Question: Produce a descriptive caption suitable for publication.
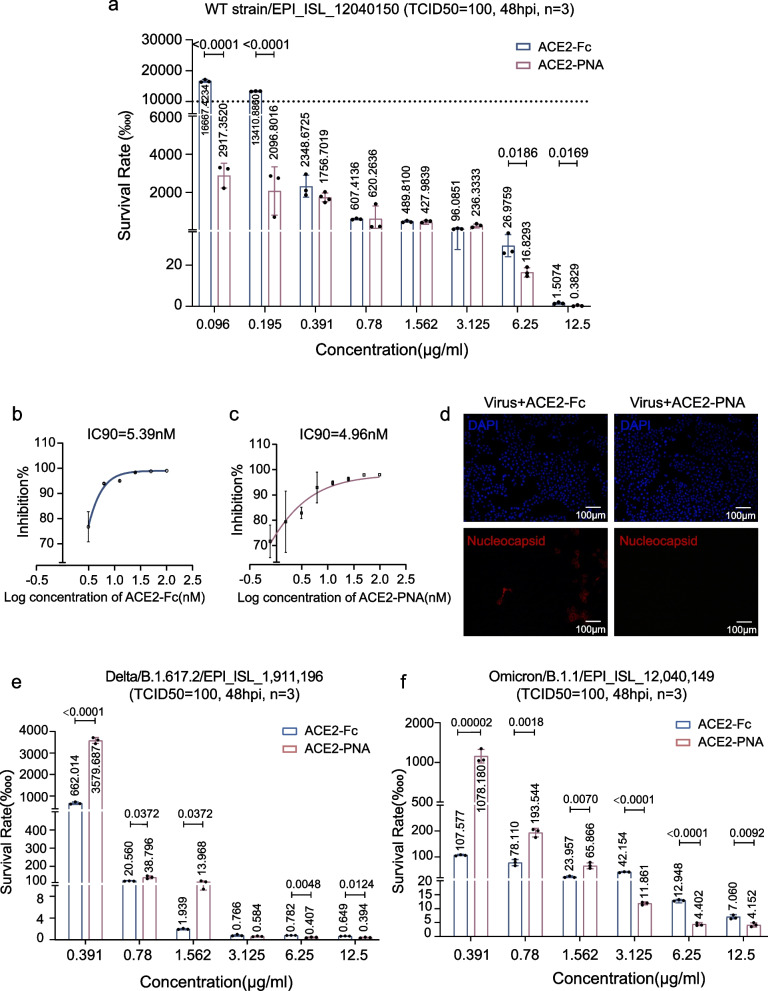
Answer: ACE2-PNA exhibits superior antiviral efficacy over ACE2-Fc in live virus experiments. a Inhibition of SARS-CoV-2 wild-type strain (EPI_ISL_12040150) infection in Vero E6 cells (TCID50 = 100) by ACE2-Fc or ACE2-PNA. b-c IC 90 values of ACE2-Fc ( b ) and ACE2-PNA ( c ) against SARS-CoV-2 wild-type strain (EPI_ISL_12040150) infection in Vero E6 cells, derived from the dose–response data in ( a ) using GraphPad Prism 10. d Immunofluorescence images of Vero E6 cells infected with SARS-CoV-2 wild-type strain (EPI_ISL_12040150) in the presence of 6.25 μg/mL ACE2-Fc or ACE2-PNA. Intracellular viral particles were detected using anti-SARS-CoV-2 nucleoprotein rabbit monoclonal antibody. Cell nuclei were labeled with DAPI. Scale bar:100 μm. e–f Inhibition of SARS-CoV-2 Delta/B.1.617.2/EPI_ISL_1911196 ( e ) or Omicron/B.1.1/EPI_ISL_12040149 ( f ) infection in Vero E6 cells (TCID50 = 100) by ACE2-Fc or ACE2-PNA. For panels ( a ) ( e ) ( f ), the Y-axis represents relative viral survival rate normalized to the untreated control group. Data are mean ± SD ( n = 3). Statistical significance was determined by multiple unpaired Student's t -tests. Only comparisons with P < 0.05 are indicated with connecting lines and values on the figure